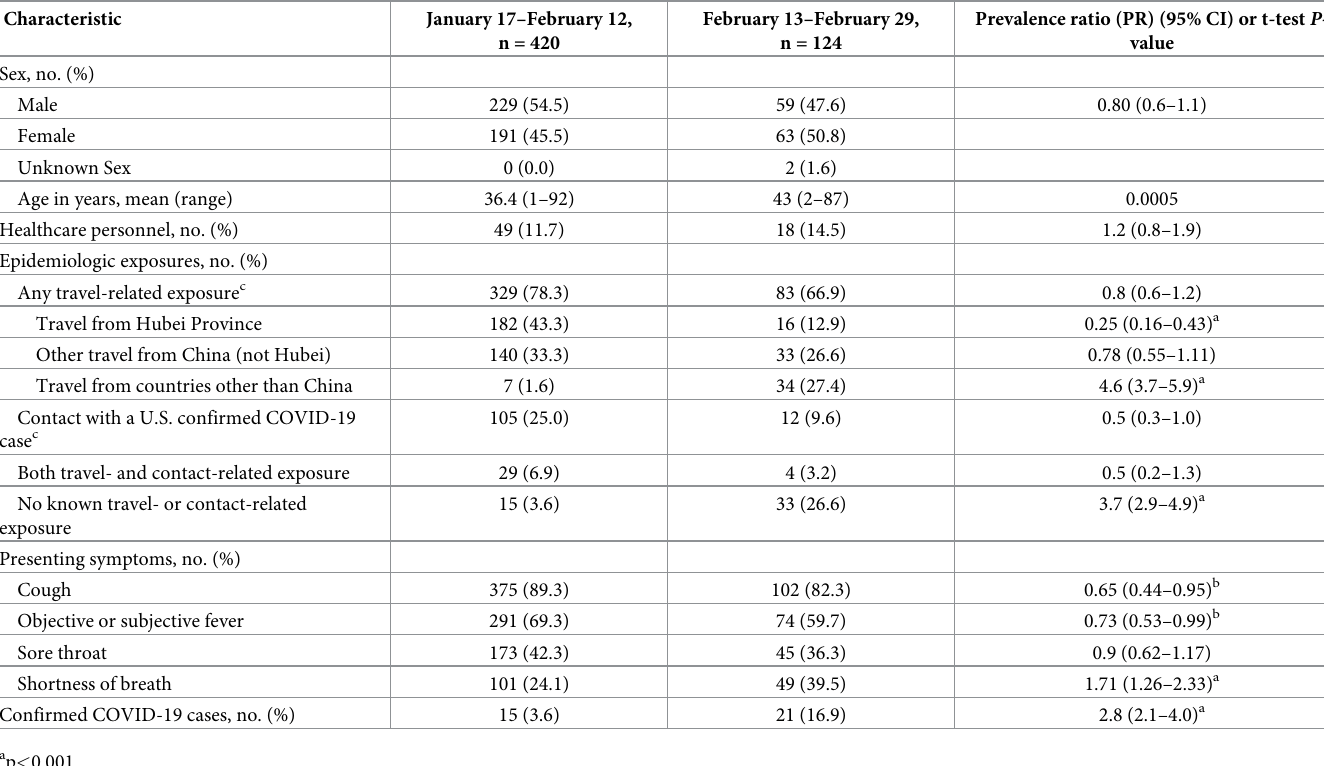
Table 3. Characteristics of persons under investigation for COVID-19, United States, January 17–February 12 and February 13–29,